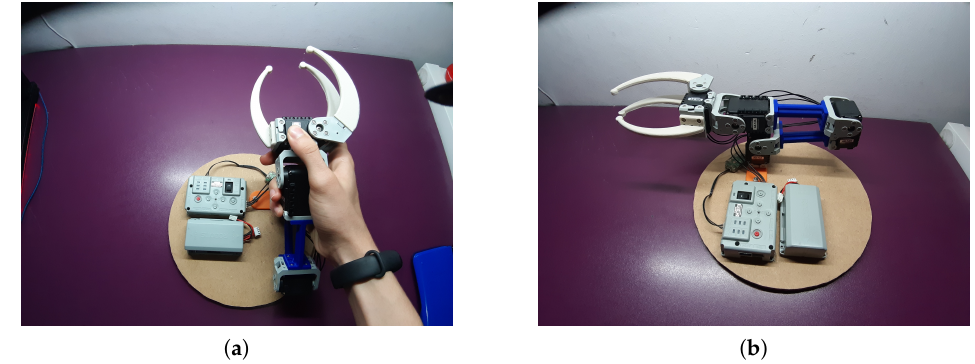
Figure 27. Student Project to implement a Master–Slave system to control the robot arm at a distance. ( a ) Frontal view, ( b ) side